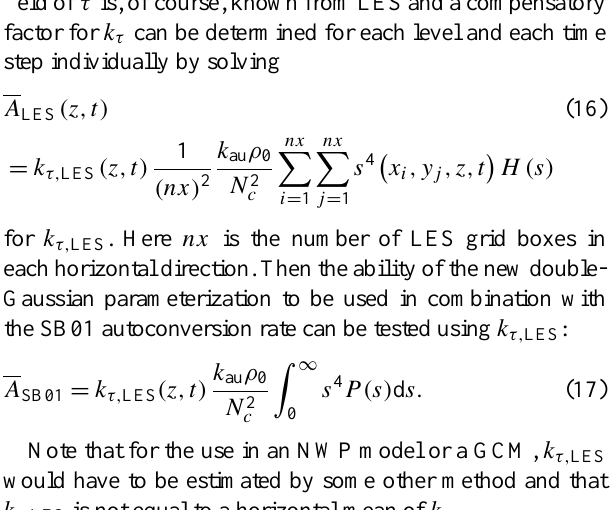
Fig. 9. Profile of the autoconversion rate in ASTEX after 25 h of simulation. Note the logarithmic scale on the x axis. Notation: LES: autoconversion rate calculated using the full 3D-field of LES data, SG: single-Gaussian parameterization, DG: double-Gaussian parameterization using the new closure equations, DG L01: double-Gaussian parameterization using the closure equations from Larson et al. (2001a).